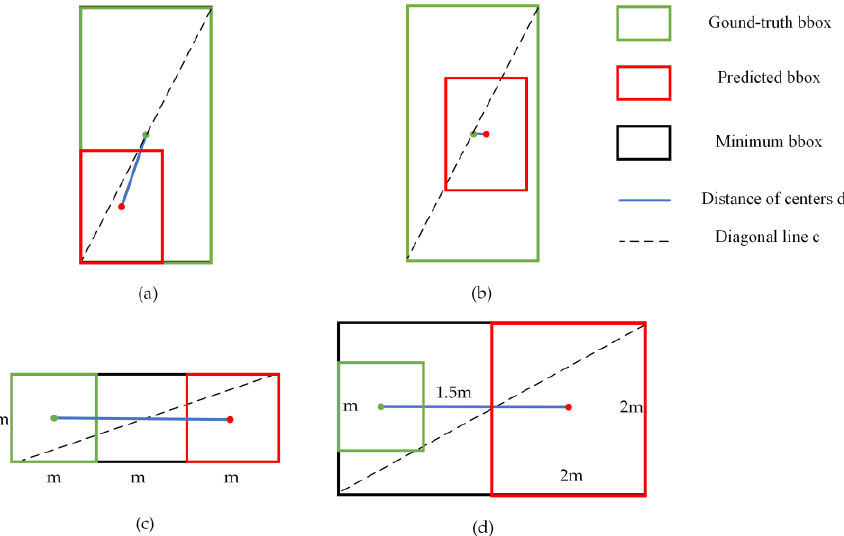
Figure 5. Illustration of CIoU loss. CIoU loss takes the IoU , distance of centers, and aspect ratio into consideration and is conducive to model training. ( a , b ) indicate that the relationship of ground-truth box and predicted box in different cases can be evaluated by calculating the distance of the two box centers; ( c , d ) illustrate that the detection results can be evaluated by the aspect ratio when the distance of centers is unchangeable.